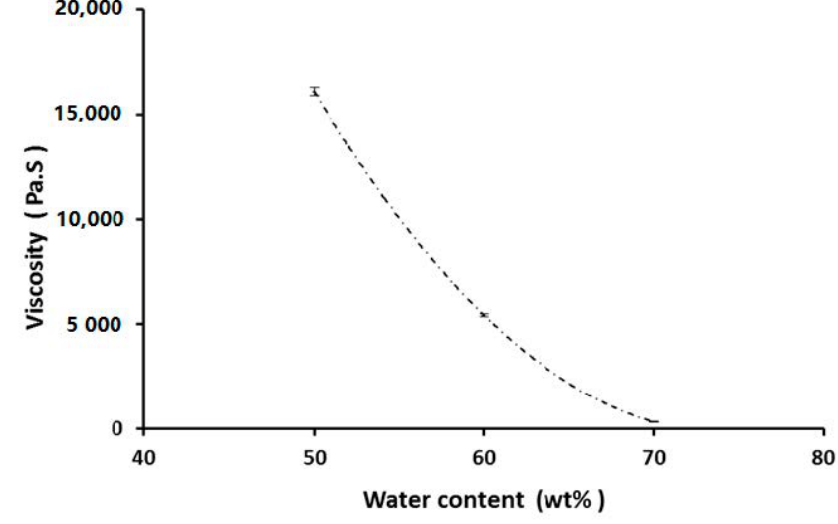
Figure 4. Influence of tap water content (wt%) on the viscosity of hydrogels.